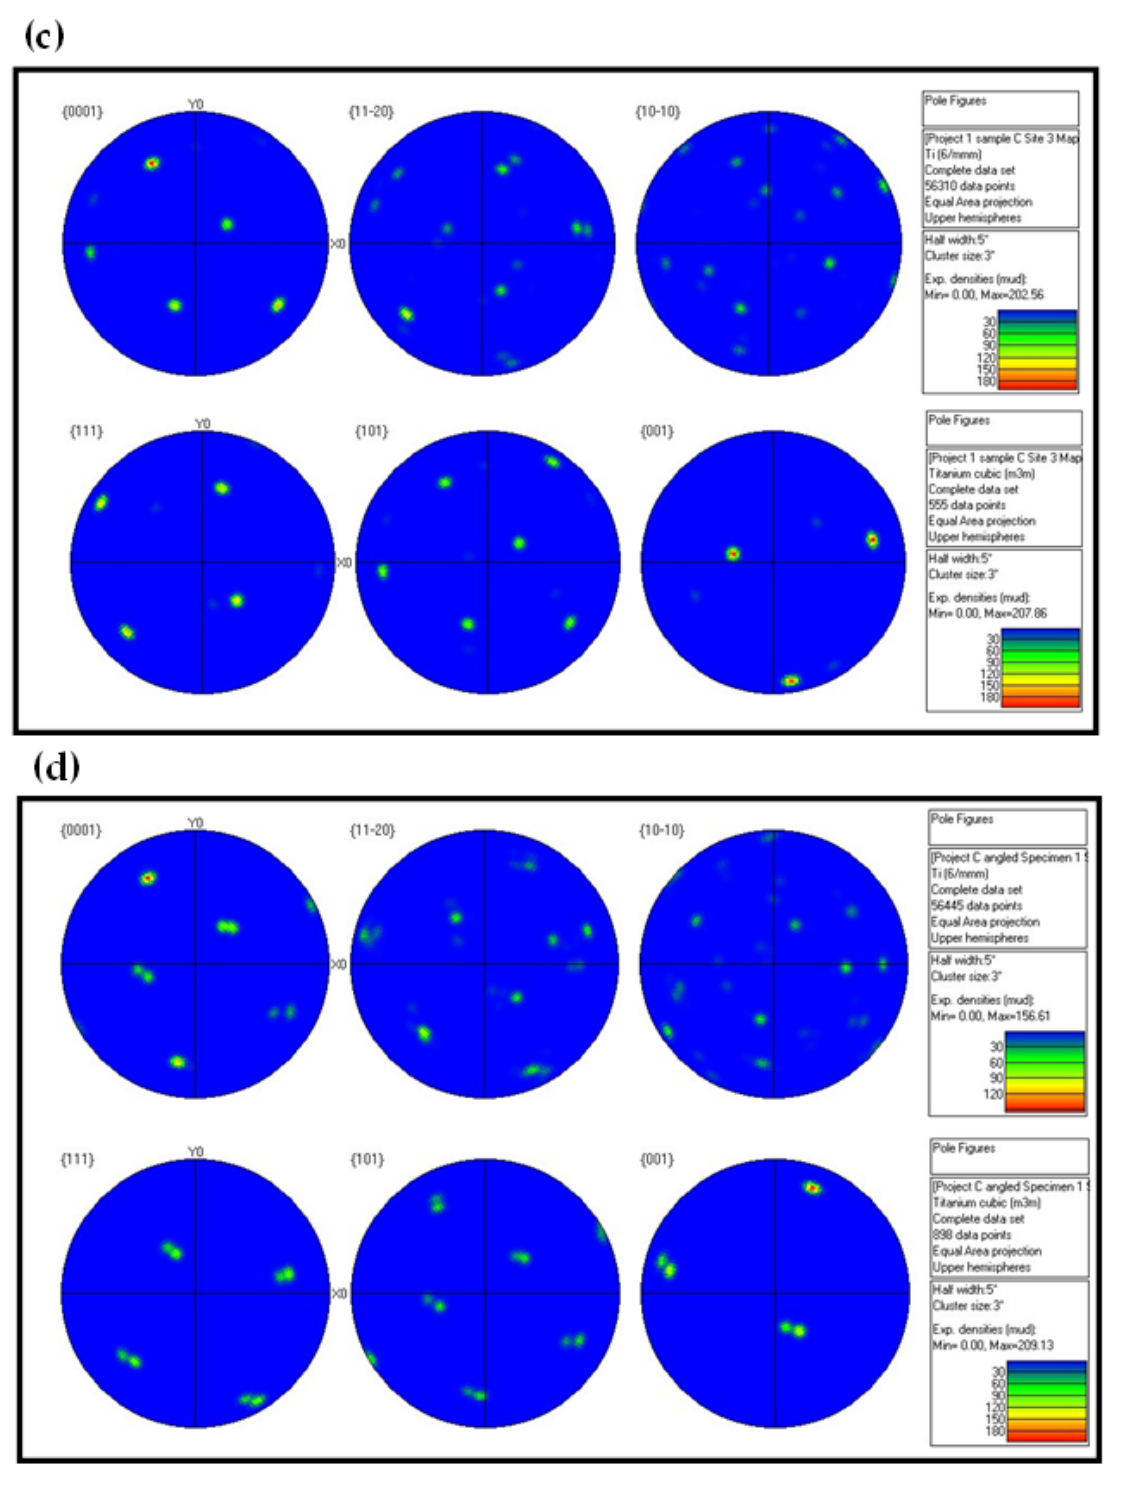
Figure 13. Pole figures corresponding to α -phase (top) in principle orientations {0001}, {01-10}, and {-12-10}, and β (bottom) in principle orientations {111}, {101}, and {001}, for: ( a ) wrought Ti6Al4V sample, facet 1; ( b ) wrought Ti6Al4V sample, facet S1; ( c ) EBM Ti6Al4V sample, facet 1; ( d ) EBM Ti6Al4V sample, facet S1.